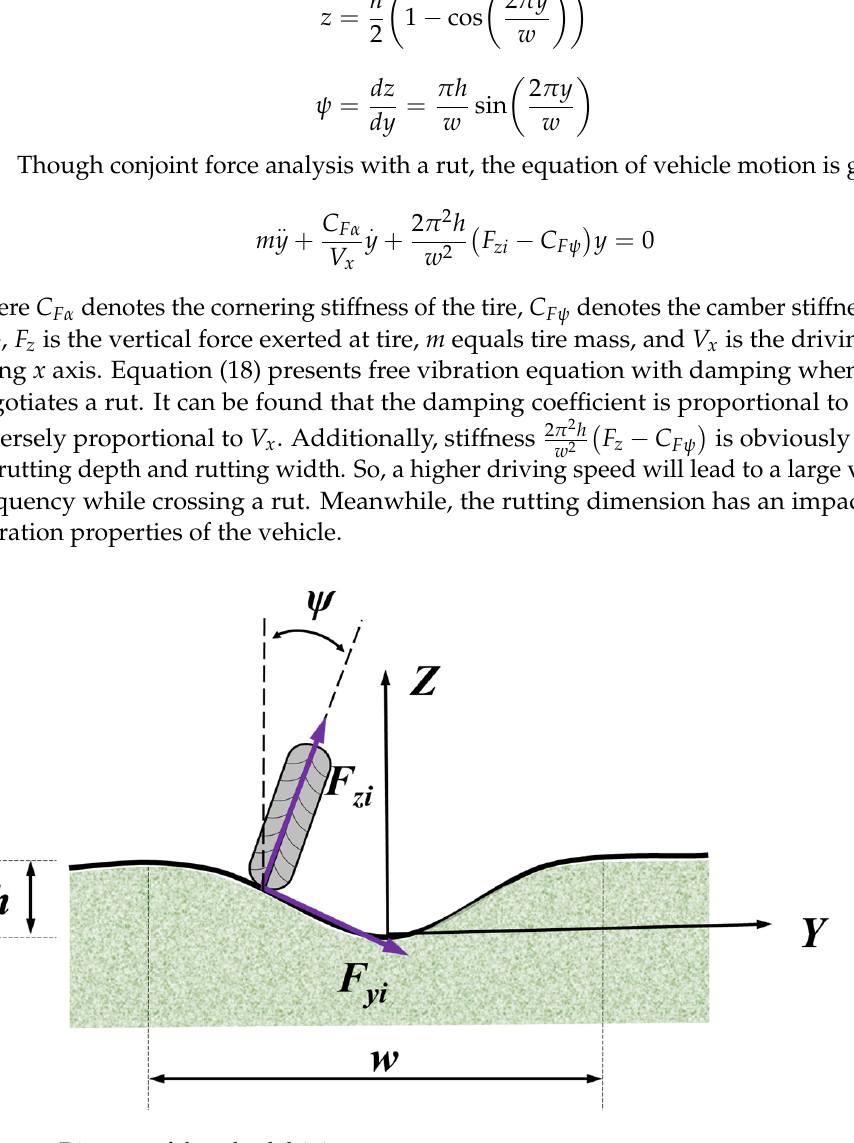
Figure 5. Diagram of the wheel driving across a rut.